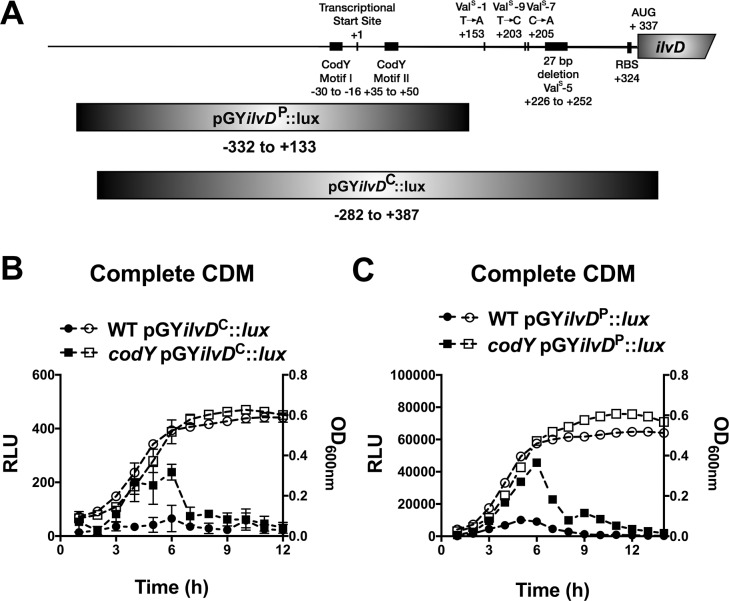
Characterization of cis and trans regulation of ilvD expression.A) Diagram of the regions cloned into the pGY::lux vector to create pGYilvDP::lux and pGYilvDC::lux. B,C) Strains were pre-grown in complete CDM to mid-exponential phase and then sub-cultured into complete CDM in a 96-well plate. Luminescence (left axis, filled shapes) and OD600nm (right axis, open shapes) were read hourly. ValSup is abbreviated to ValS. Data are the mean +/- SD of three biological replicates.